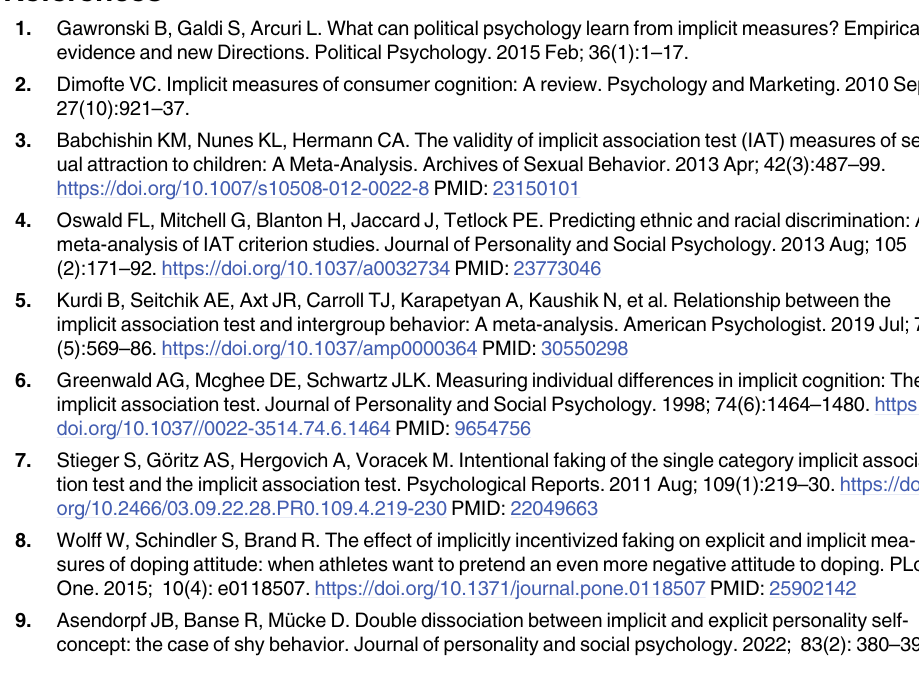
S1 Table. Category labels and items for the past driving under the influence implicit asso- ciation test. S2 Table. Category labels and items for the acceptability driving under the influence implicit association test. S3 Table. Risk factors for drunk driving outcomes (Study 1). S4 Table. Risk factors for drunk driving outcomes (Study